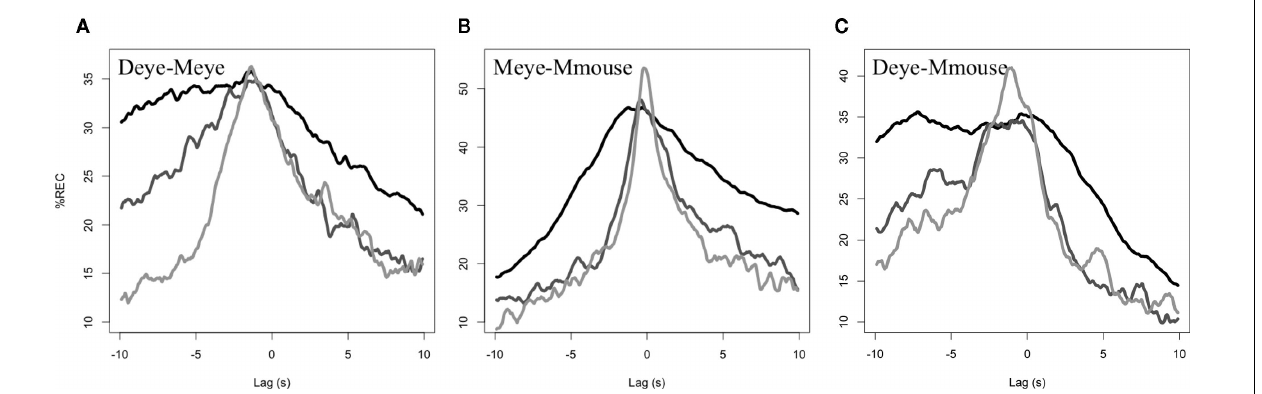
FIGURE 3 | Mean lag profiles across dyads. Round (A) is black, round (B) mid grey, and round (C) light grey.